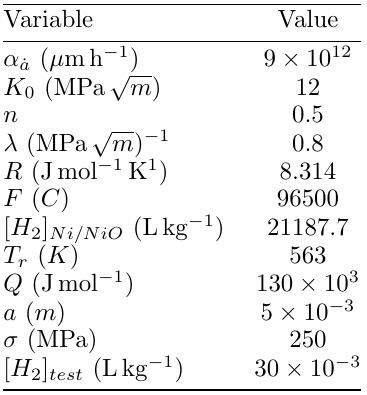
Fig. 13. Plot of the law that transforms the KAM into the deformation (cid:15) . The linear part is fitted on the macroscopic strain (cid:15) 0 and the maximum is set at (cid:15) max = 20% . Table 1. Numerical values of the coefficients appearing in the crack propagation speed (Eq.